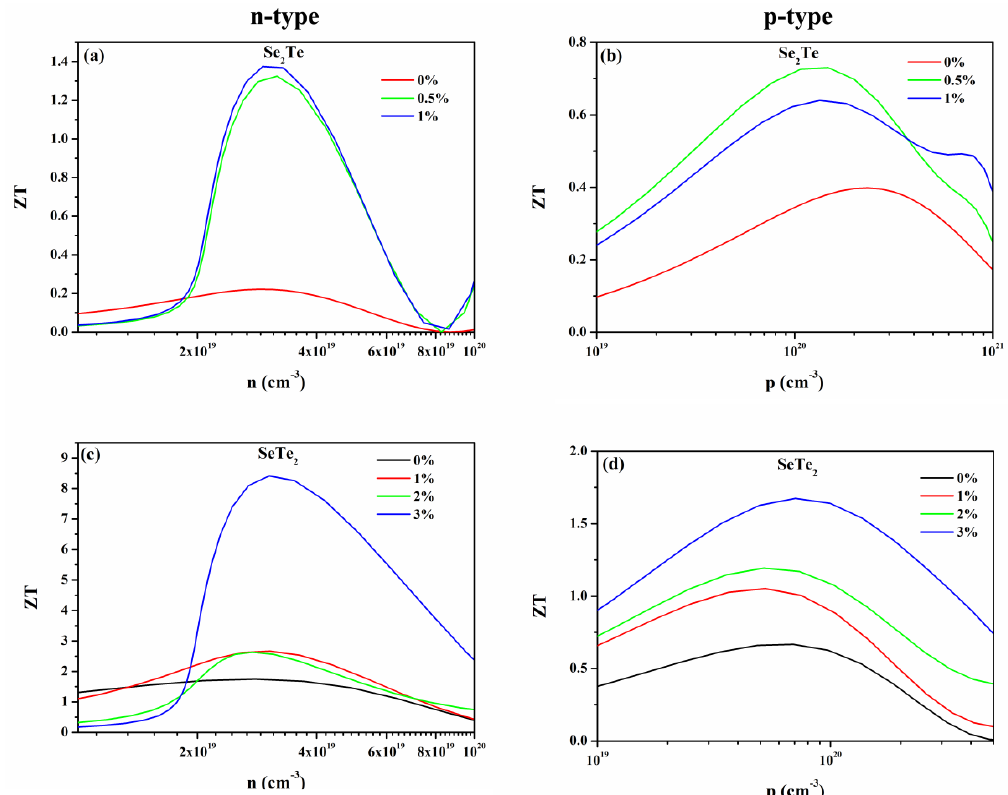
Figure 10. (Color online) The strain-dependent figure of merit ZT of ( a , b ) Se 2 Te and ( c , d ) SeTe 2 monolayers at room temperature as a function of concentration, respectively.